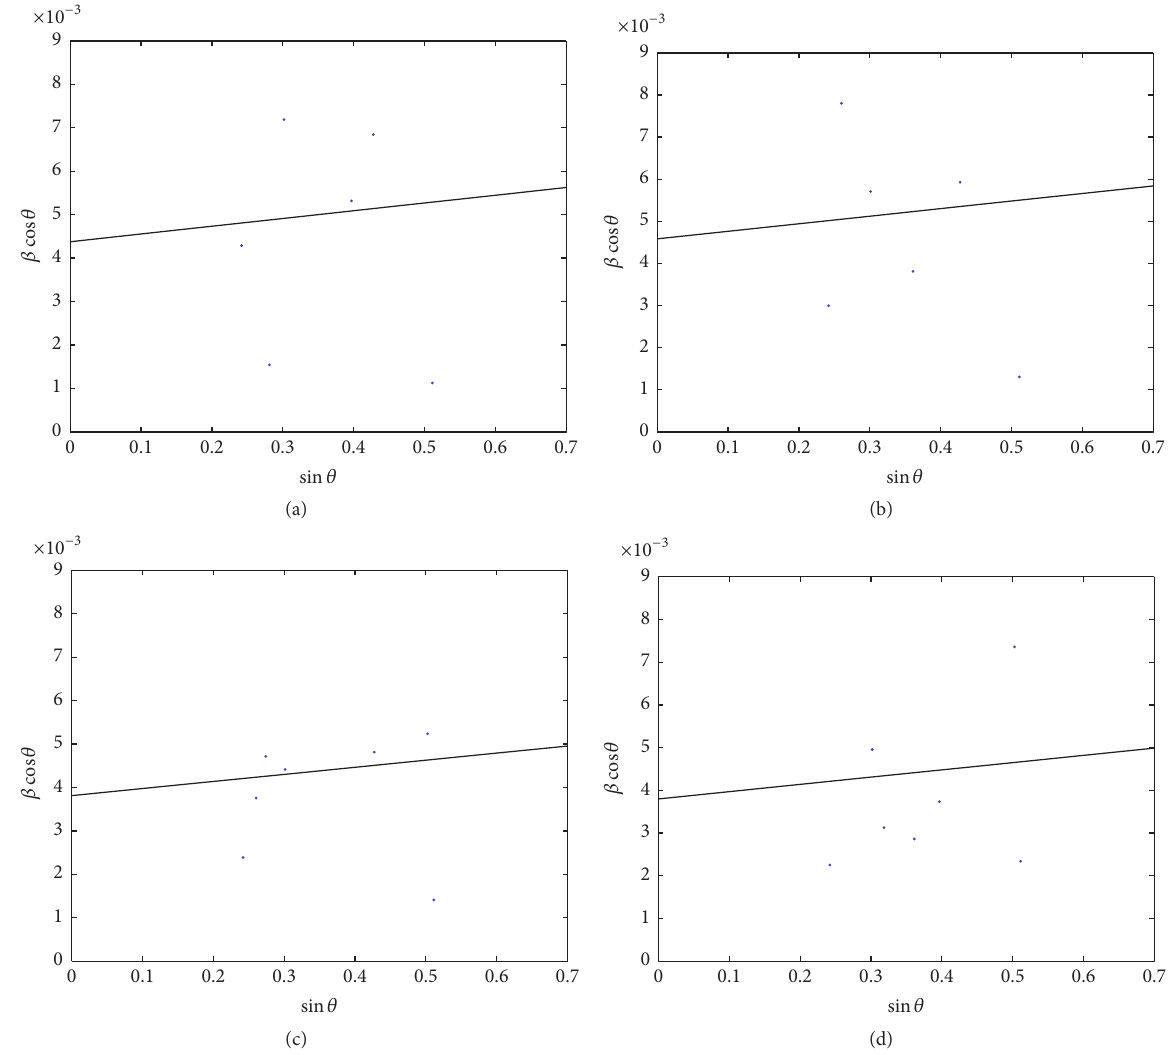
Figure 2: Plot of 𝛽 cos 𝜃 versus sin 𝜃 of Ta/Nd/NdFeB ( 𝑥 nm)/Nd/Ta ((a) 𝑥 = 450 ; (b) 𝑥 = 600 ; (c) 𝑥 = 750 ; (d) 𝑥 = 900 ) films.